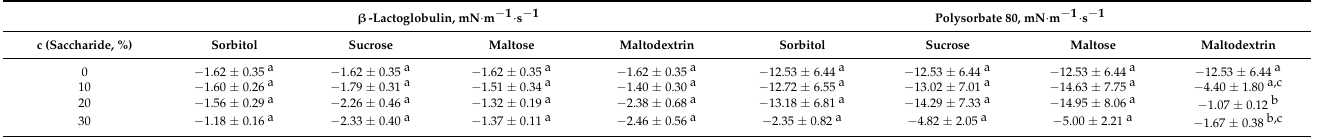
Table 2. Calculated surface activity of samples with polysorbate 80 and β -lactoglobulin in the presence of added saccharides with content between 0% and 30% at 20 ◦ C.